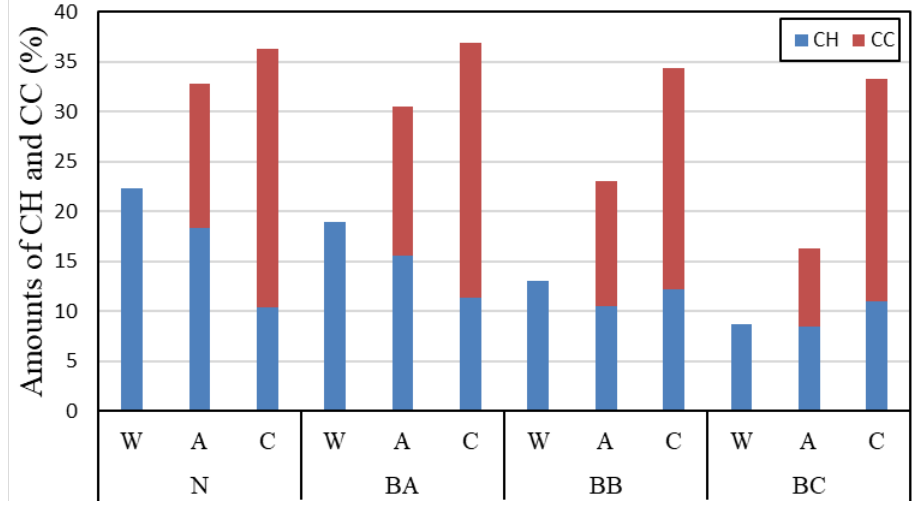
Figure 5. Amount of calcium hydrate (CH) and calcium carbonate (CC) in carbonated cement paste.